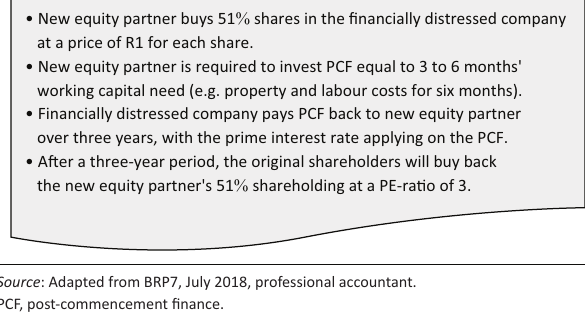
FIGURE 2: Post-commencement finance agreement when selling shares to a new equity